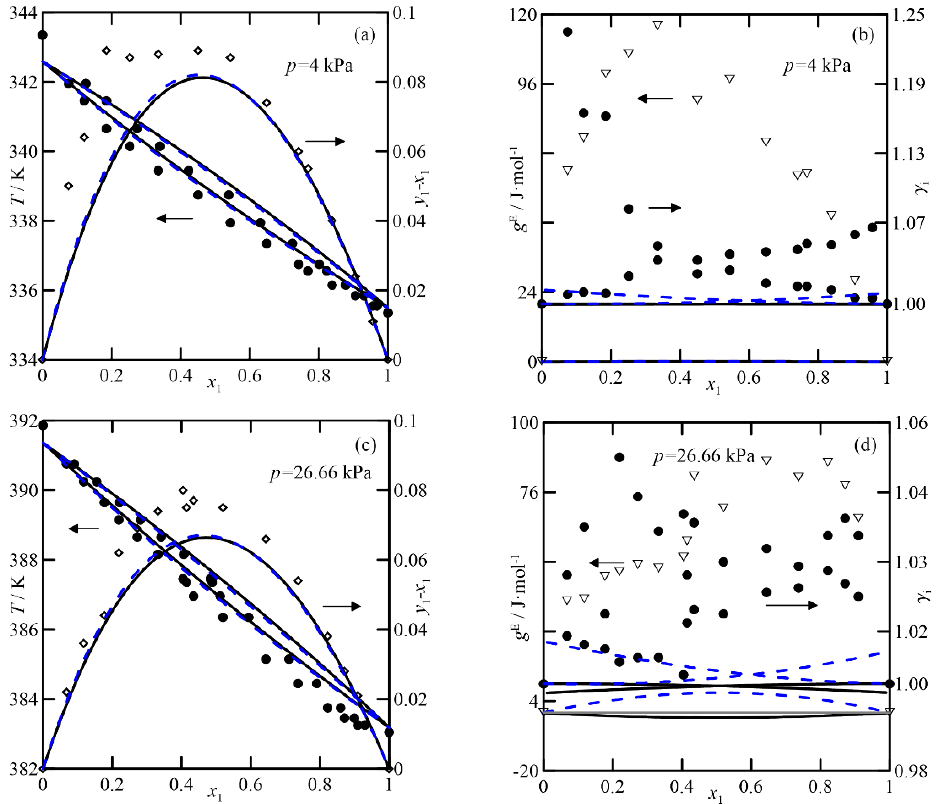
Figure 4. Iso- p VLE at 4 kPa ( a , b ) and at 26.7 kPa ( c , d ) of cyclohexanone + 2-methylcyclohexanone [3]; (—-) UNIFAC-DM; (- - -) COSMO-RS. ( • ) T ,x,y (a,c)/ γ i ( b , d ); ( ¯ ) (y − x ), x ; ( σ ) g E / RT.